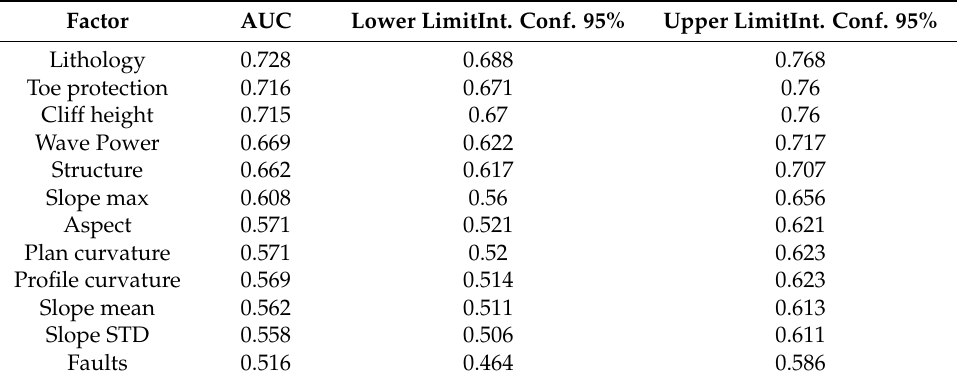
Table 3. Receiver operating characteristics (ROC) curves and area under the curve (AUC) of Logistic Regression model for each independent predisposing